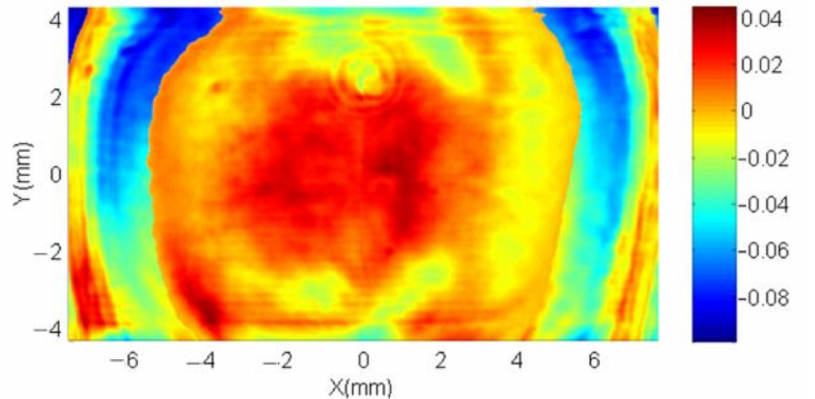
Figure 15. The compensation phase difference of the proposed method and the iterative phase compensation method.